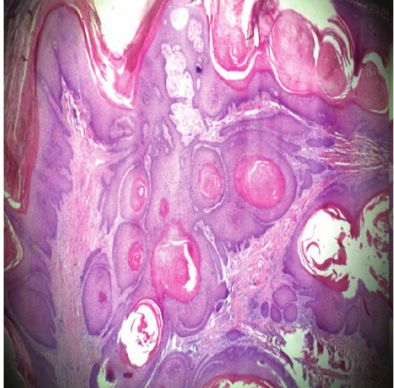
Figure 1: Large ulcerating lesion on the plantar surface of the calcaneus of the right foot.